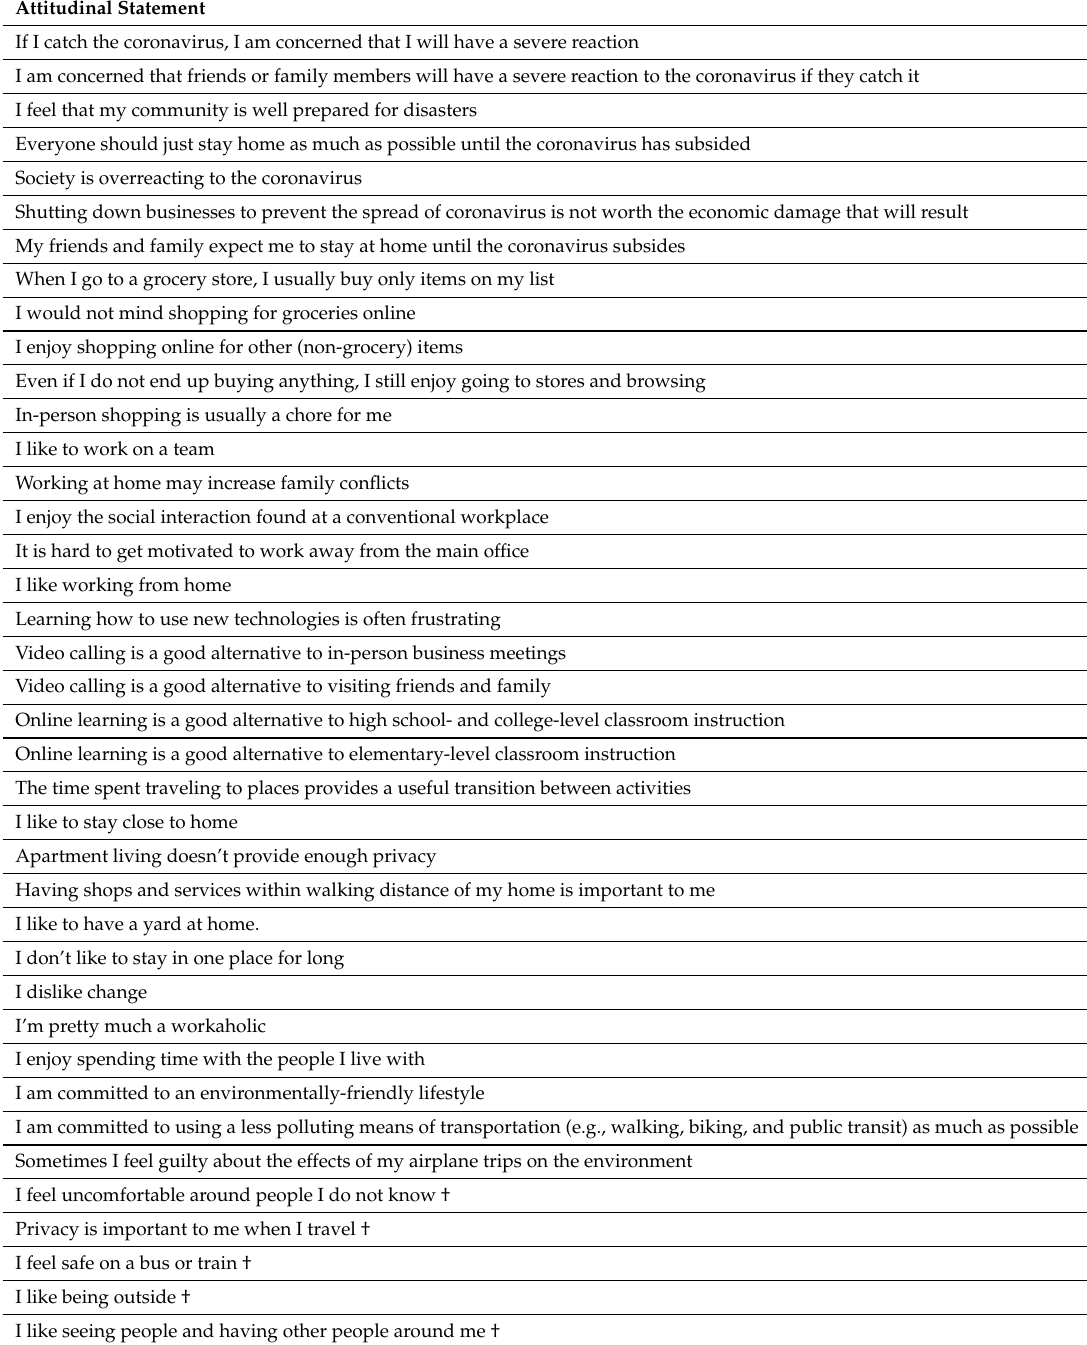
Table A2. All attitudinal statements used in factor